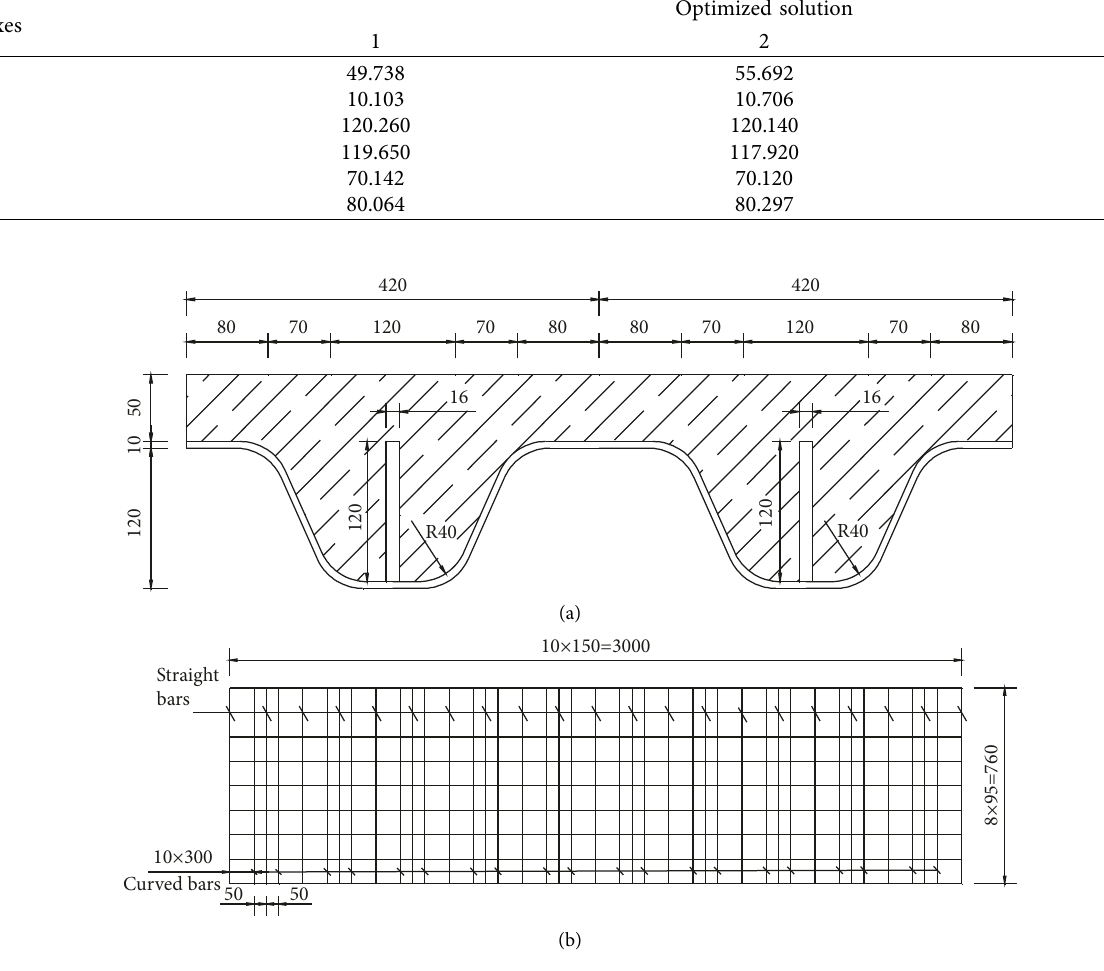
Figure 9: Optimized composite bridge deck. (a) Cross section. (b) Steel-bar